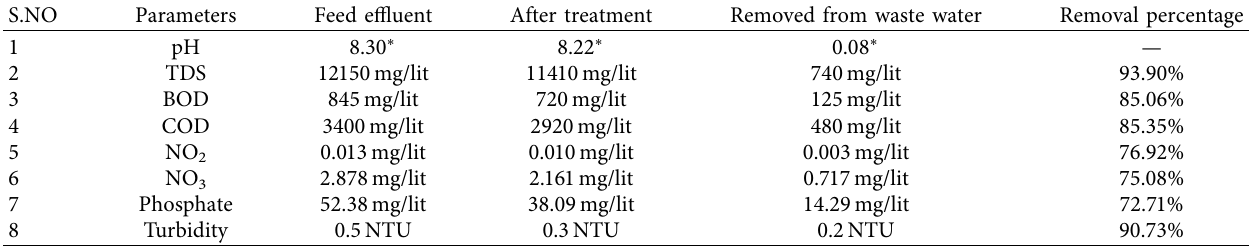
Table 4: Physical and chemical characteristics of feed and treated effluent—5 days retention time.